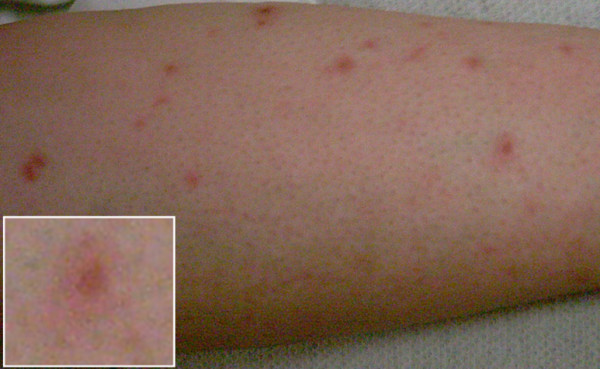
Skin lesions. Right lower extremity with multiple itching nodules, excoriations from scratching and general lichenification of the skin (inset: enlarged lesion with excoriation and reddish halo).